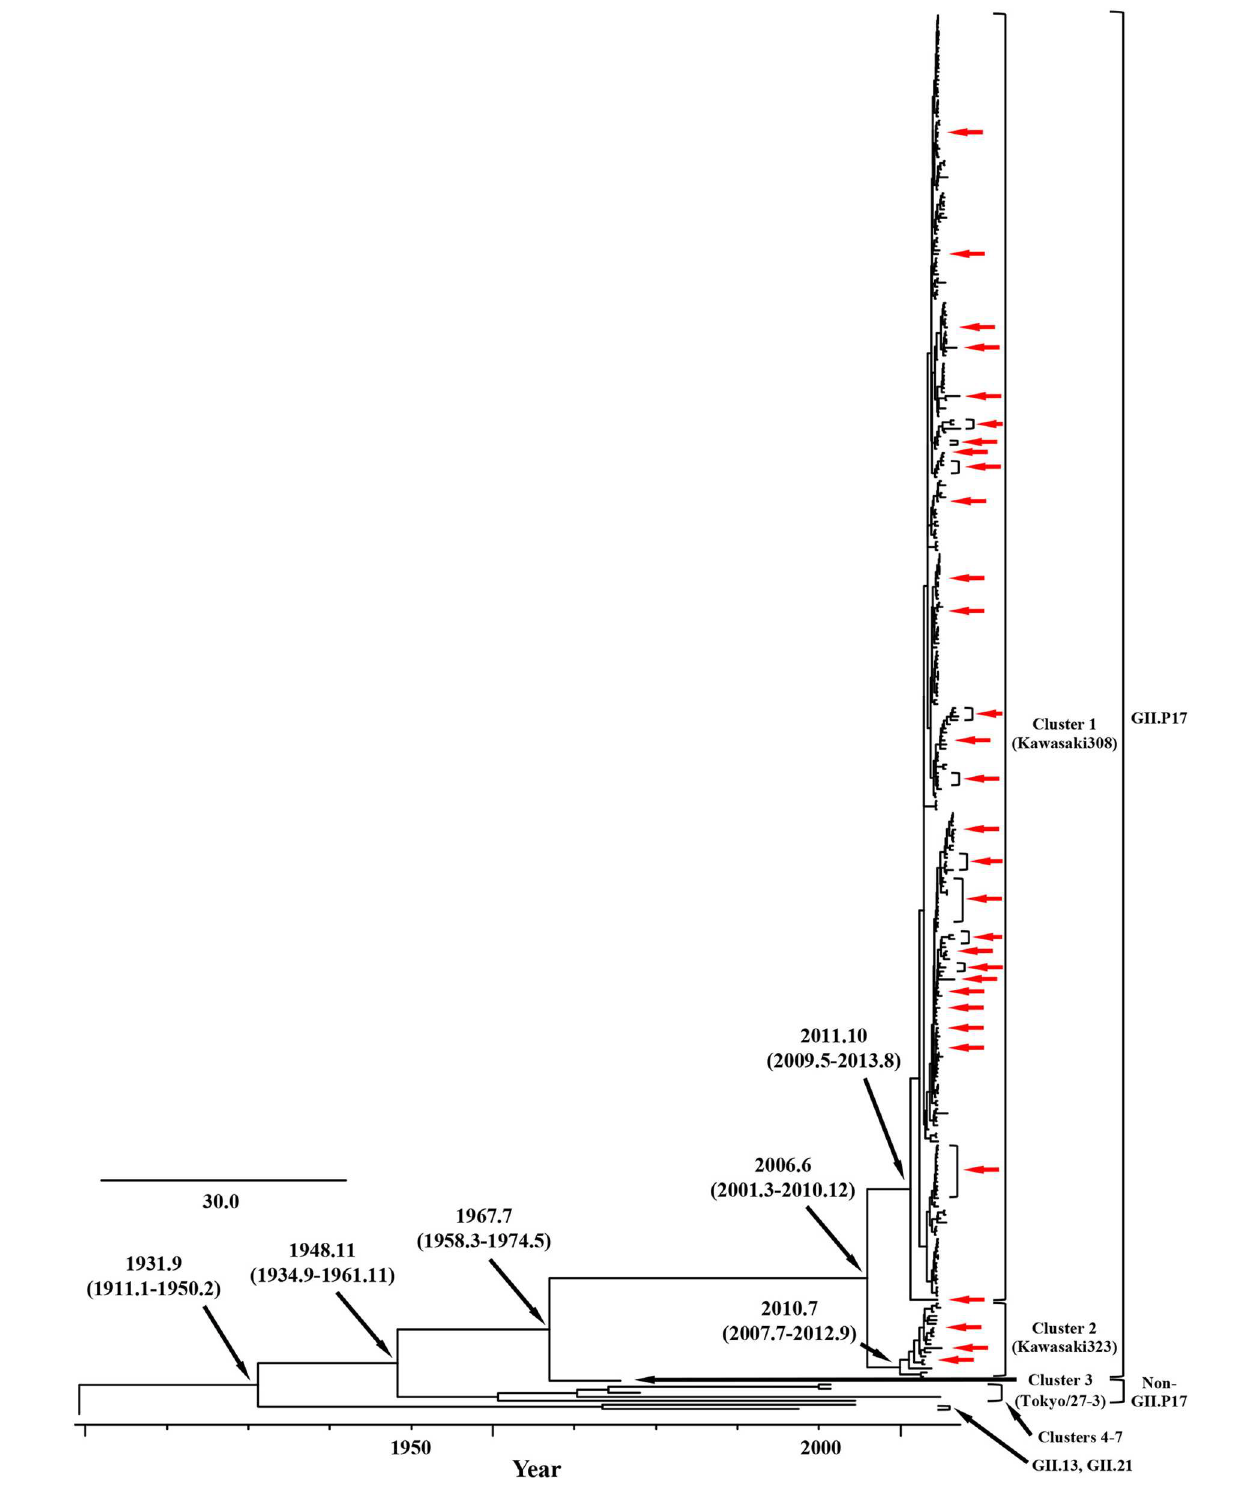
FIGURE 1 | Time-scaled phylogenetic trees of the full-length VP1 region of HuNoV constructed using the Bayesian MCMC inference. The visualization of the tree is enlarged to focus on GII.17, GII.13, and GII.21. The values within parentheses indicate the 95% HPDs for each divergent year, and red arrows indicate the Japanese samples collected in this